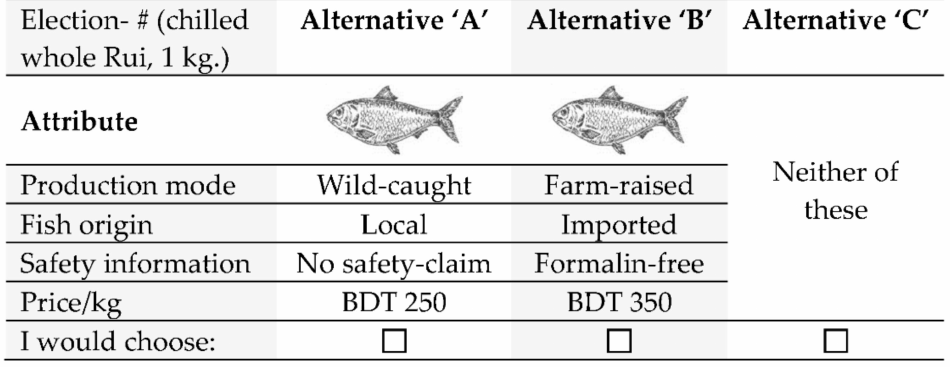
Figure 2. Example of a choice set. # = 1, 2, 3,